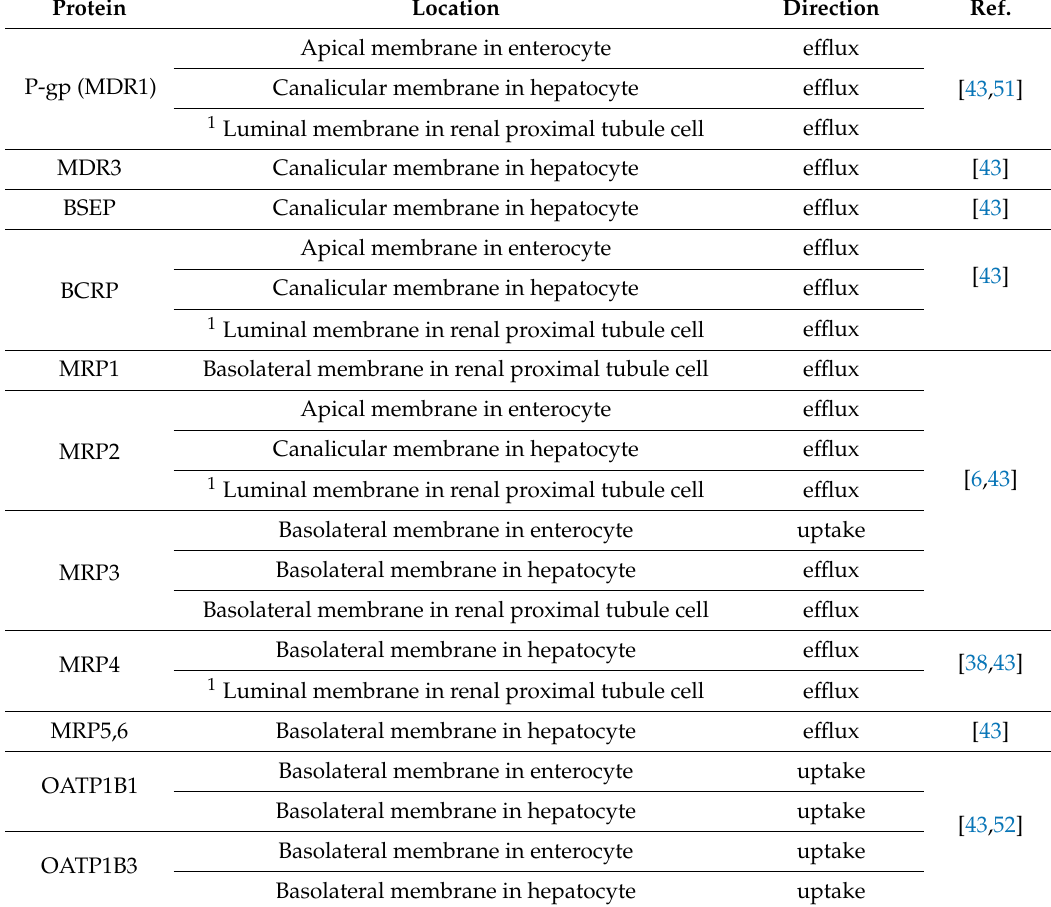
Figure 1. Representative transporters and metabolic enzymes in enterocytes ( A ), hepatocytes ( B ) and renal proximal renal tubules ( C ), which are possibly involved in DDIs. Table 1. Characteristics of transporters mediating the occurrence of clinically relevant DDIs. Protein